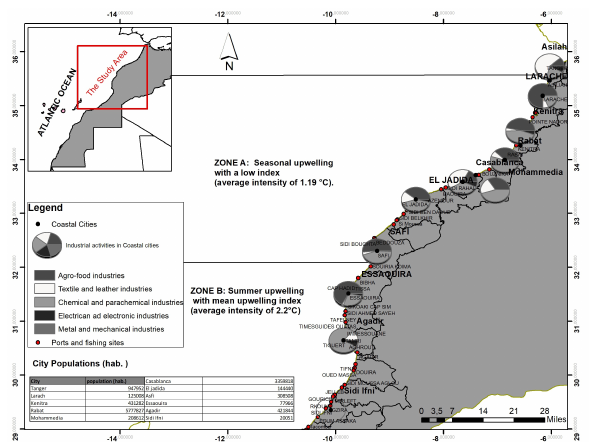
Figure 1. The location of the studied Area between Tangier (35 ◦ N) to Sidi Ifni (29 ◦